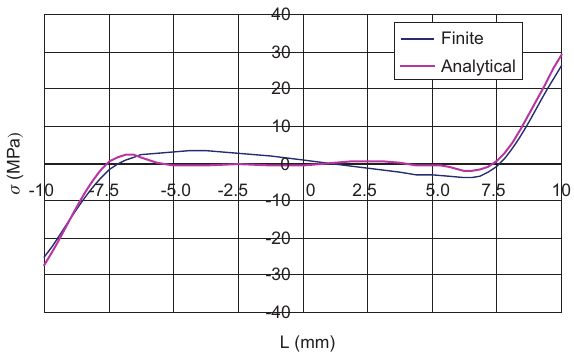
Figure 9 Peel stress distribution along the adhesive for t